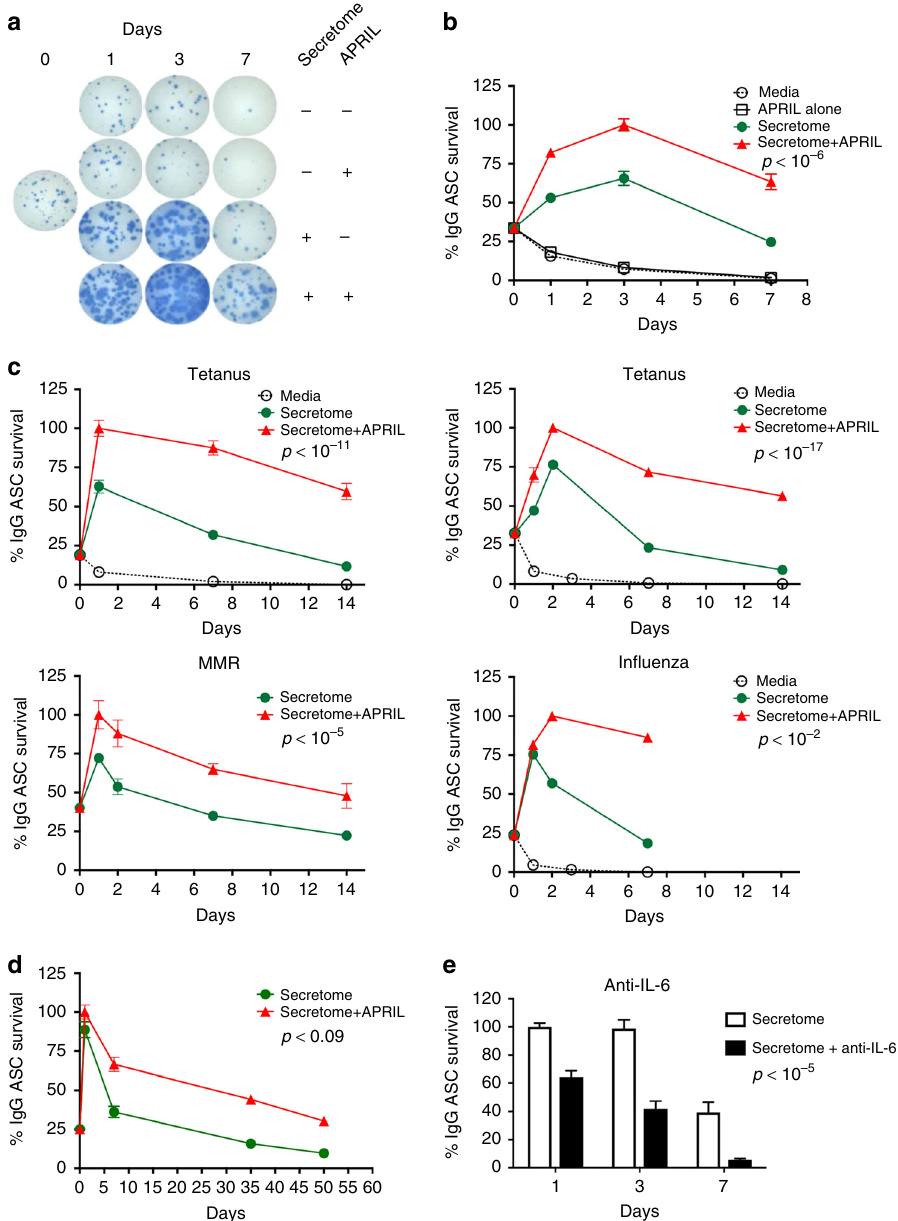
Fig. 3 APRIL together with the MSC secretome enhances blood ASC survival. a , b Blood ASC survival is enhanced by the MSC secretome with exogenous APRIL. First two rows: sorted blood ASC were cultured in R10 alone or in media with exogenous APRIL for 7 days. Second two rows: blood ASC were cultured in MSC secretome alone or the secretome with APRIL. Blood ASC immediately from FAC sorting are shown (day 0). Representative images of Elispot wells are shown. Graphic plot of % survival of IgG ASC in media alone (R10) (open circles), APRIL alone (open squares), secretome alone (green circles), or secretome + APRIL (red triangles) ( p < 10 -6 ; liner regression modeling between secretome alone and secretome + APRIL). c Exogenous APRIL together with the MSC secretome enhances ASC survival in short-term cultures. Blood ASC from four different subjects after vaccination were cultured in media alone (open circles), secretome alone (green circles), or secretome + APRIL (red triangles). Percentage of IgG Elipsots normalized to maximal frequency on days 1 – 3. Shown are p -values between secretome alone & secretome + APRIL. d Exogenous APRIL with the MSC secretome enhances ASC survival in long-term cultures. ASC cultured with the MSC secretome (green circles) or MSC secretome + APRIL (red triangles). e Treatment of MSC secretome with anti-IL-6 antibodies (anti-IL-6) diminishes blood ASC survival. Blood ASC were cultured in MSC secretome or MSC secretome treated with anti-IL-6 for 1, 3, 7 days and IgG Elispots were performed ( p < 10 − 5 ; linear regression modeling between secretome vs secretome + anti-IL-6). The frequency of isotype controls was similar to MSC secretome. Representative of three